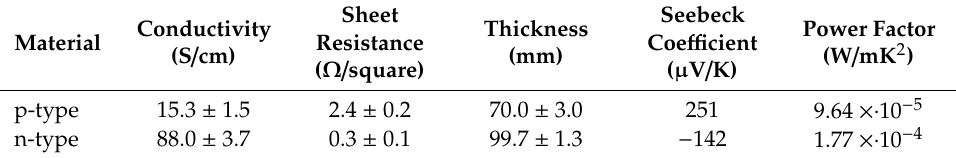
Table 4. Electrical characterization of furnace processed layers.